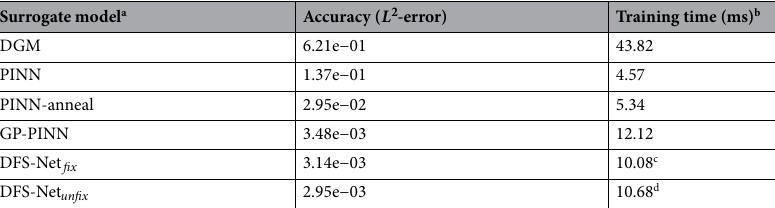
Surrogate model a Accuracy ( L 2